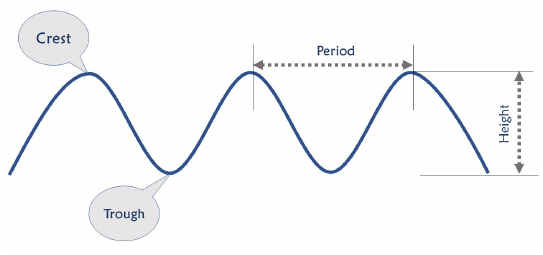
Figure 1. Ocean wave characteristics [27].